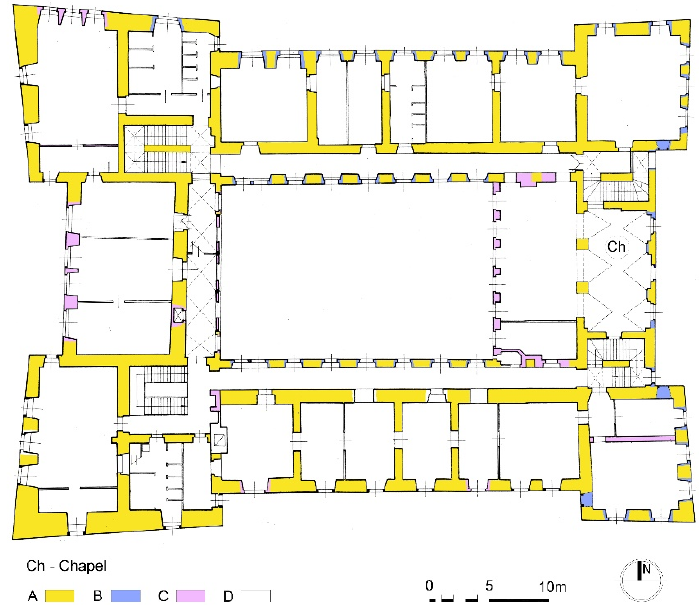
Figure 8. Prószków castle: ground floor plan with chronological stratification of the walls. Legend: A—Renaissance (approximately 1563); B—Baroque (1667–86); C—1881; D—walls unknown and from the 20th century, created by authors.